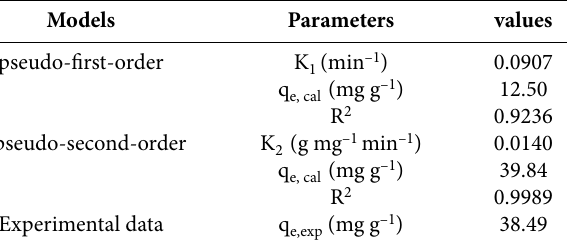
Table 1. Kinetic parameters of pseudo-first-order model and pseu- do-second-order model for MB adsorption by nanozeolite L Models